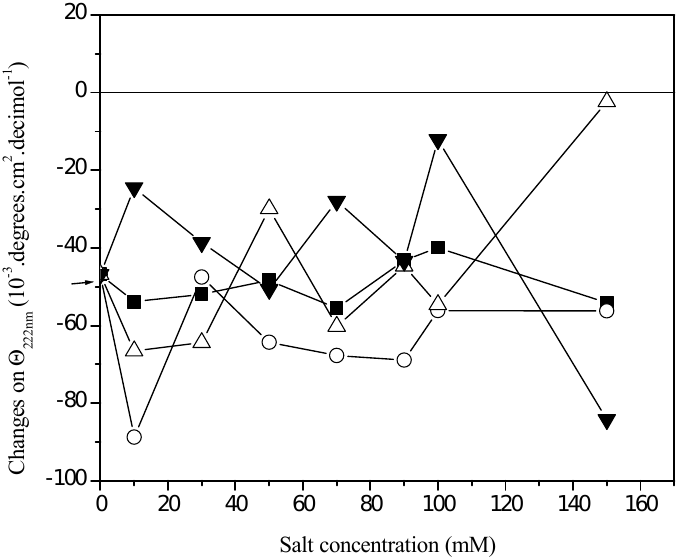
Figure 4. Effect of Hoffmeister series ions concentrations on θ of 7.36 mM Dtxd were obtained after emulsification in the presence of CH kosmotropics NaHPO analyzed by CD spectroscopy.